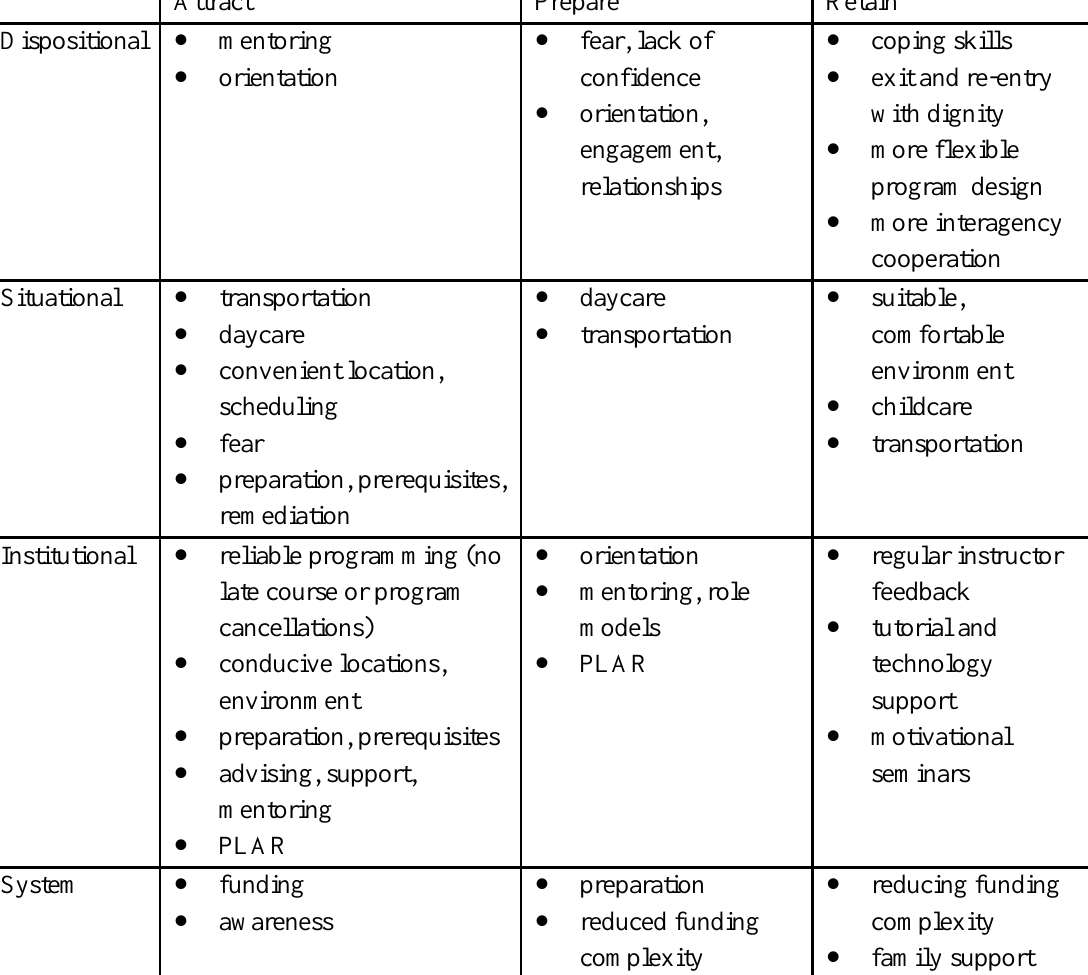
Table 3 Critical Influences on Attraction, Preparation, and Retention Attract Prepare